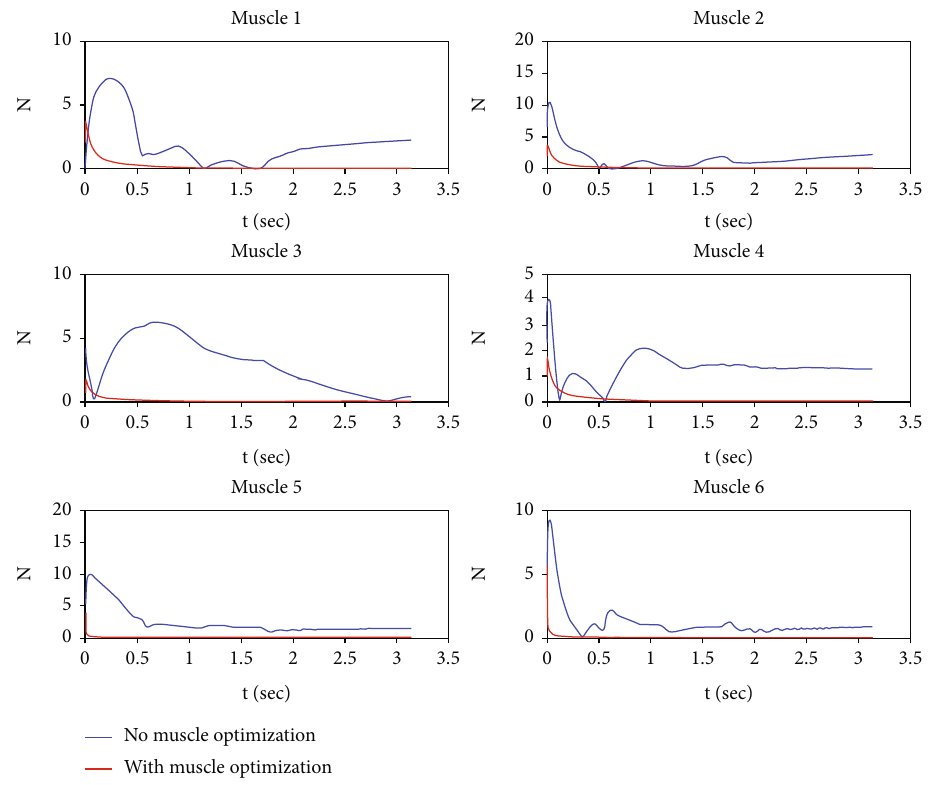
Figure 5: The input forces of each muscle during the